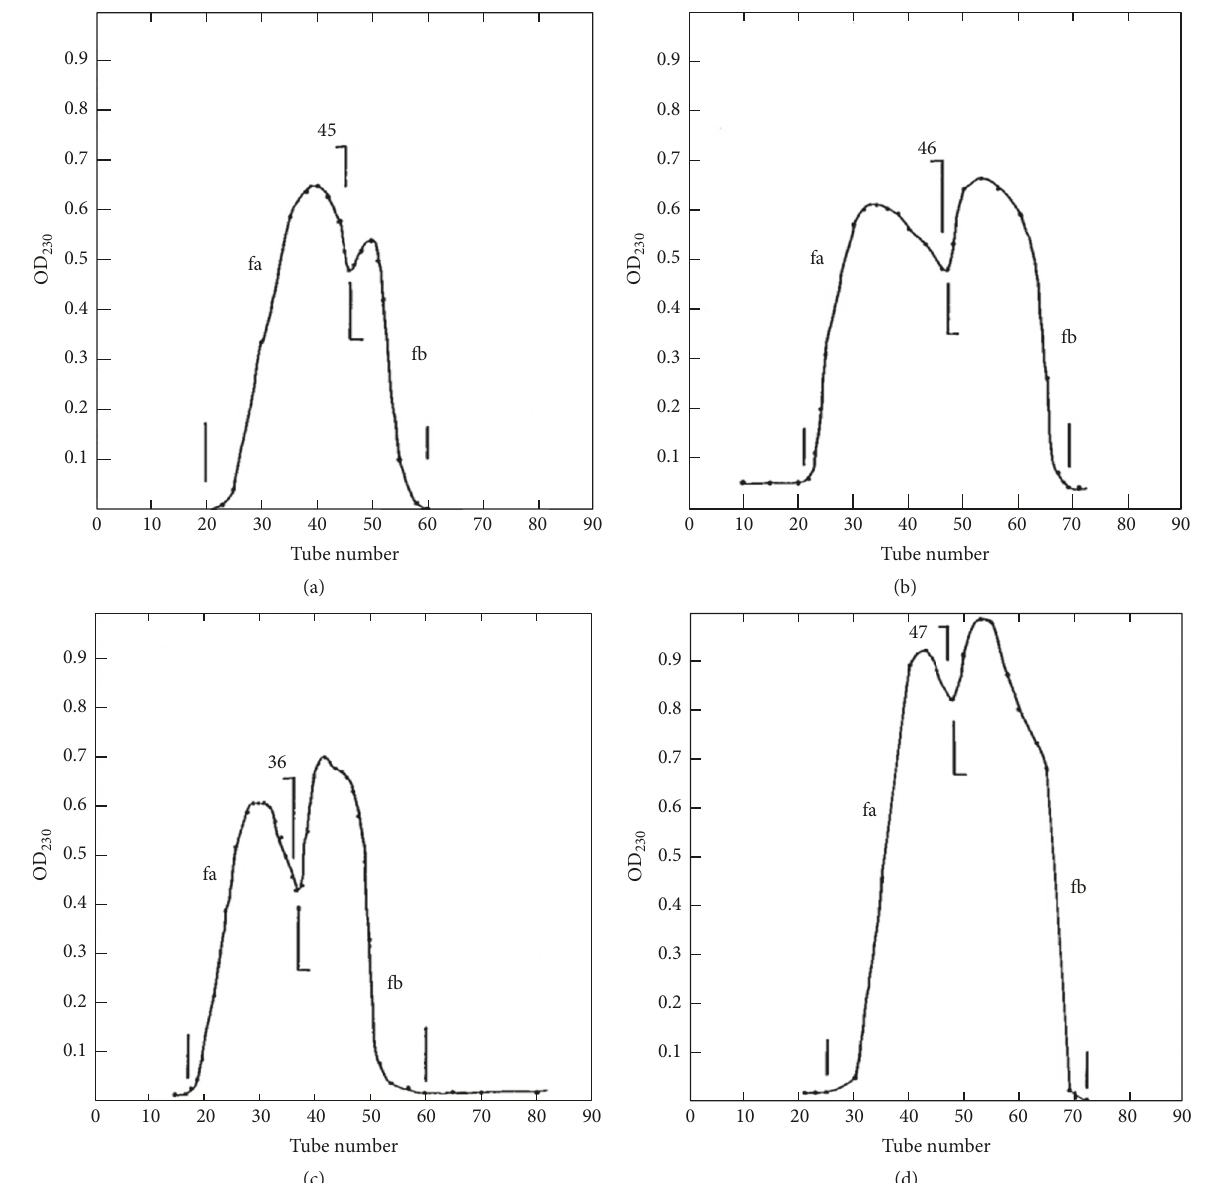
Figure 8: Gel permeation chromatograms of the reaction mixtures of Boc-Gly-L-Asp ( 5a ) at varying temperatures and times: (a) 110 ∘ C, 24 h; (b) 120 ∘ C, 24 h; (c) 150 ∘ C, 2 h; and (d) 170 ∘ C, 2h. Solid phase: Sephadex G-25F. Eluate: 0.5M acetic acid. Volume per a test tube: 3 mL. fa: ninhydrin-negative, higher molecular weight fractions; fb: ninhydrin-positive lower molecular weight fractions.